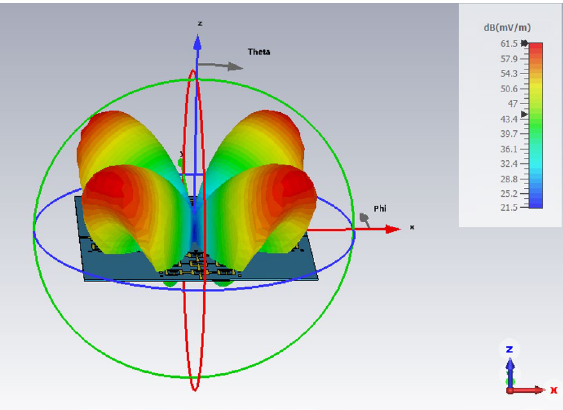
Figure 12. Simulated radiation pattern of the proposed 4-element antenna array at 4.25 GHz.